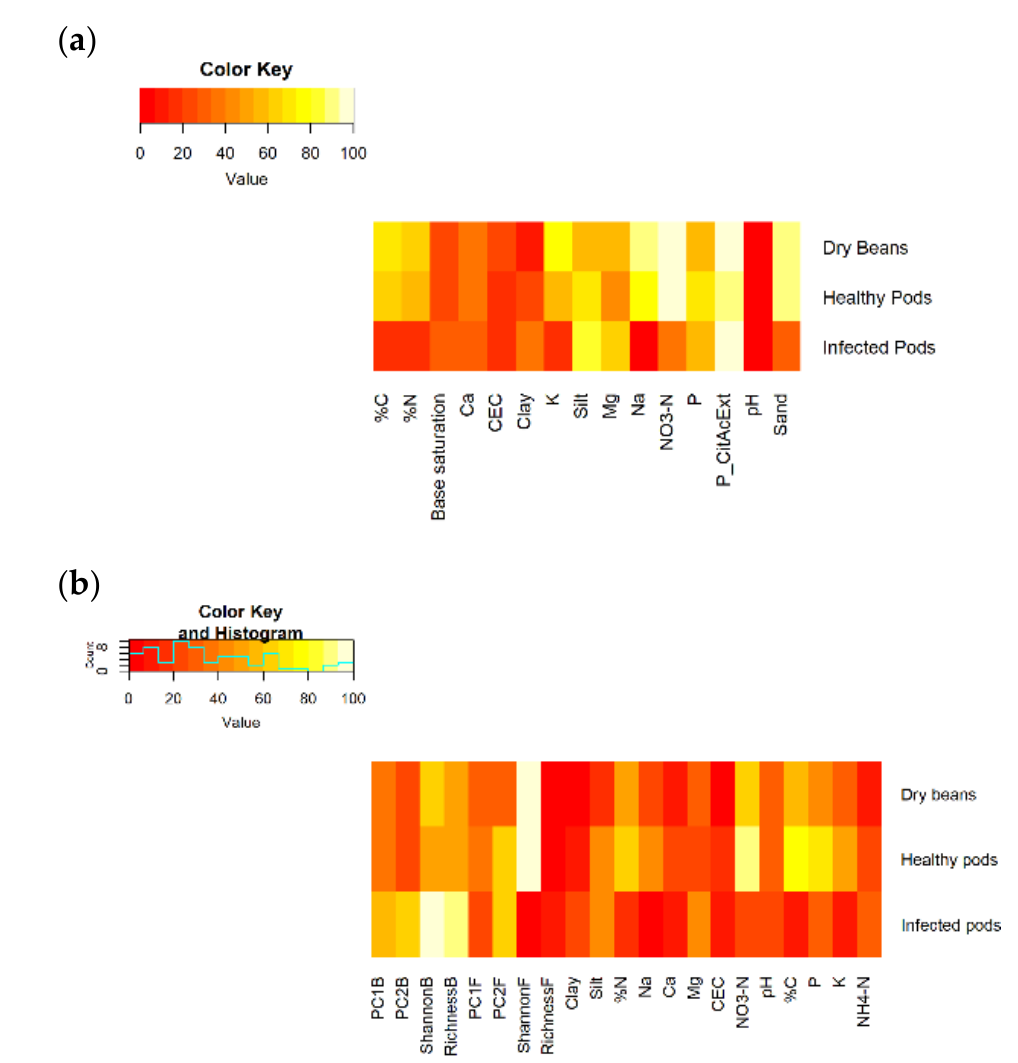
cating a better fit, than models with only soil physicochemical variables.